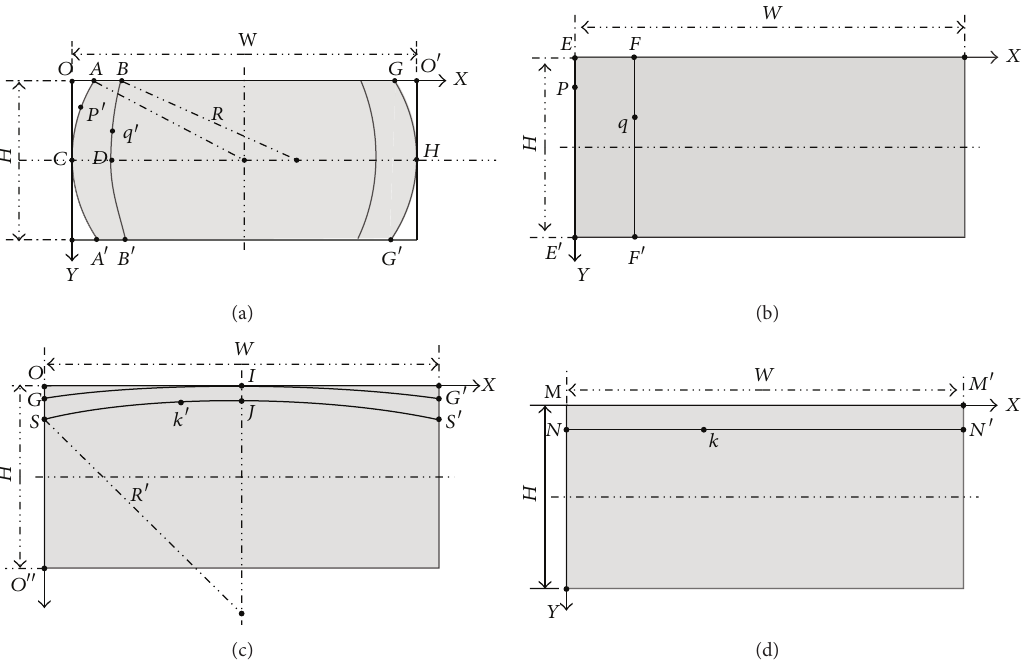
Figure 6: (a) The structure of captured fish-eye panoramic image in vertical direction. (b) VCI in vertical direction. (c) VCI in horizontal direction. (d) HVCI in horizontal